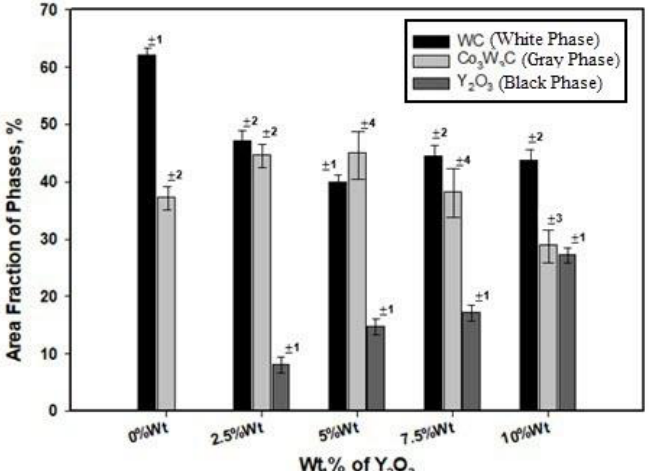
Figure 9. Bar chart of the area fraction of the three phases: WC (white phase), Co3W3C (gray phase), and Y2O3 (black phase), calculated using image analysis of the SEM micrographs shown in Figure 8.